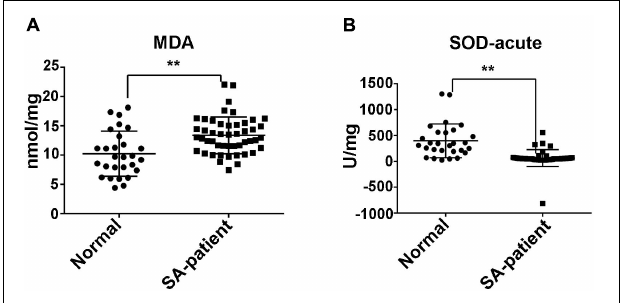
FIGURE 1 | (A) The expression of MDA in the villi of N and SA groups. (B) The expression of SOD in the villi of N and SA groups (N, normal, n = 28; SA, spontaneous abortion, n = 48), ** P <